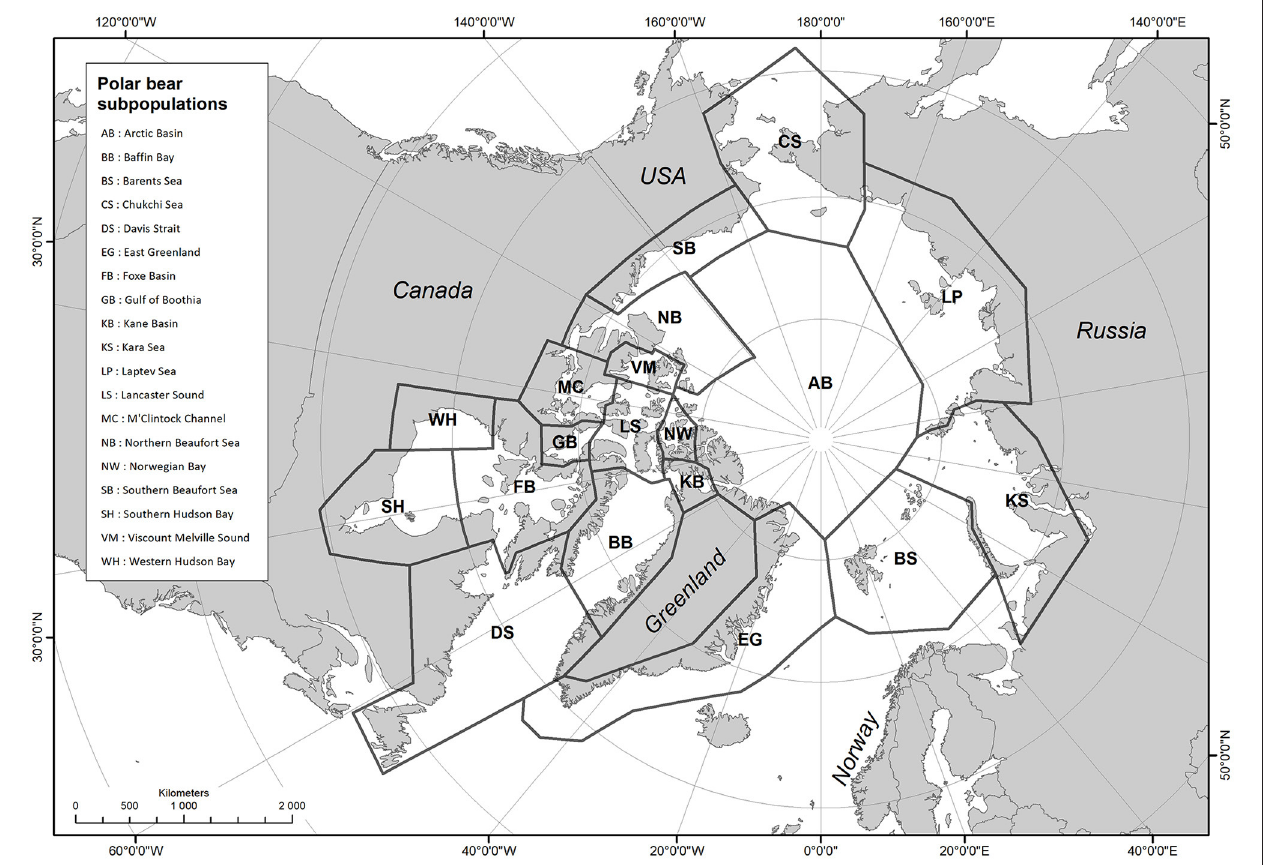
FIGURE 1 | Polar bear populations as delineated by the IUCN/SSC Polar Bear Specialist Group (after Polar Bear Specialist Group,